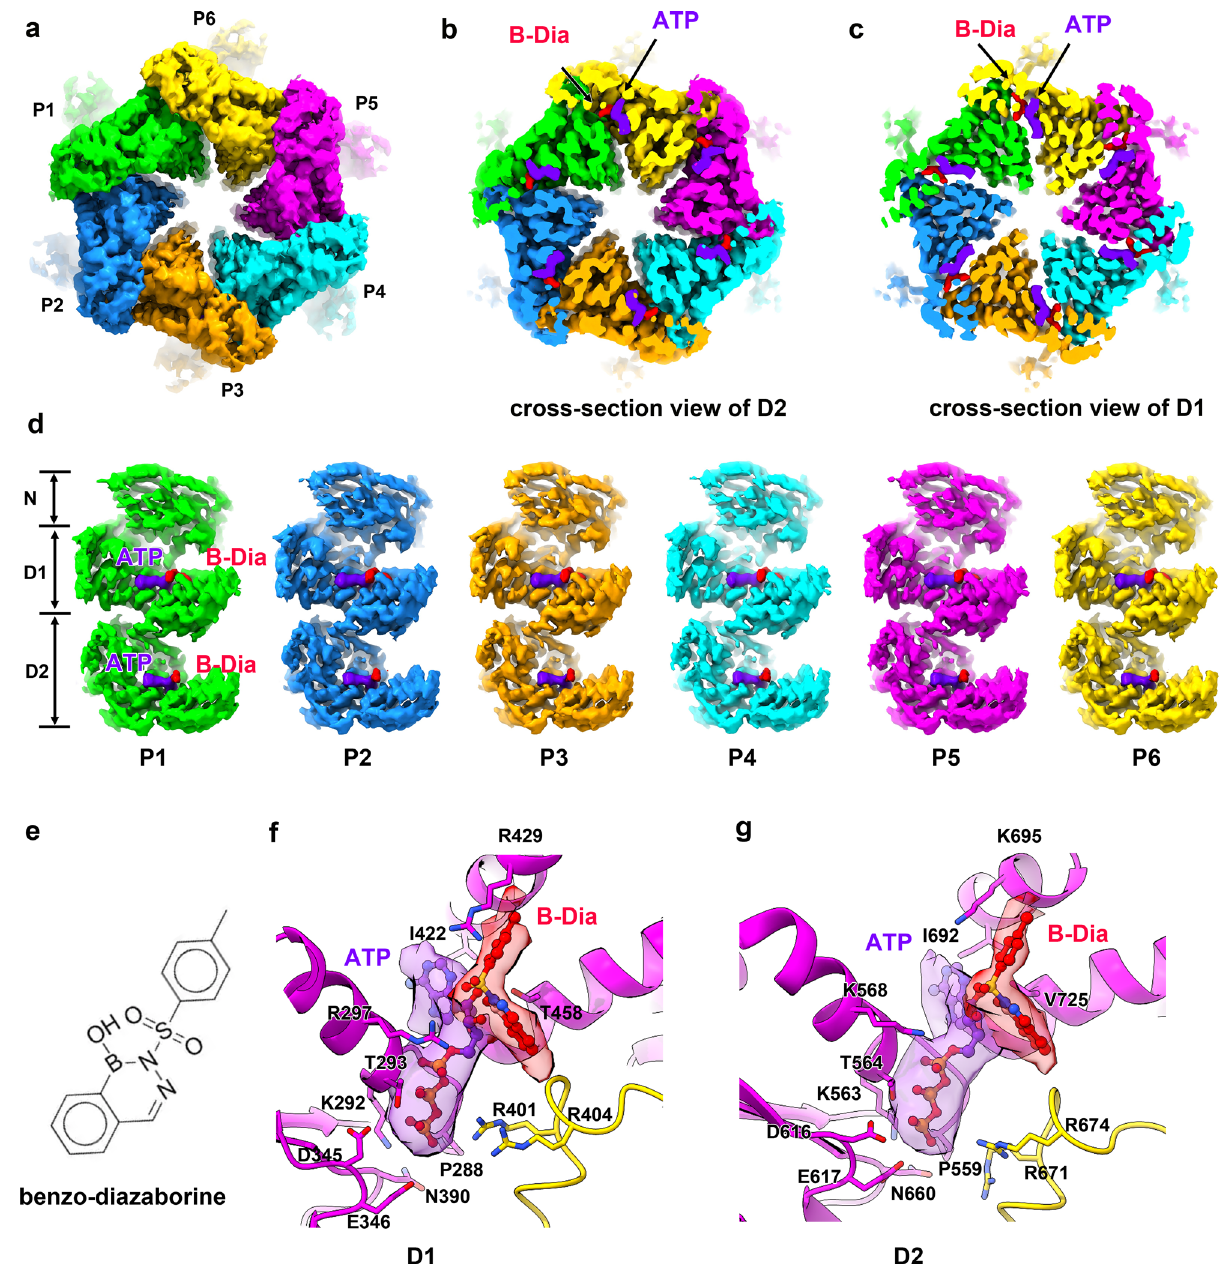
Fig. 7 | Benzo-diazaborine binds to the ATPase sites of both the D1 and D2 domains.a Thecryo-EMmap(withoutimposingsymmetry)oftheDrg1hexamerin the presence of ATP and benzo-diazaborine (B-Dia) viewed from the bottom (D2 direction).Subunits ofthe Drg1 hexamer arecolored separately. b , c Cross-section view of the D2 ( b ) and D1 ( c ) rings. B-Dia and ATP are colored red and purple, respectively. d Comparison of the six protomers, indicating that these protomers adopt a similarconformation. The binding sitesofB-Diaand ATP in the nucleotide